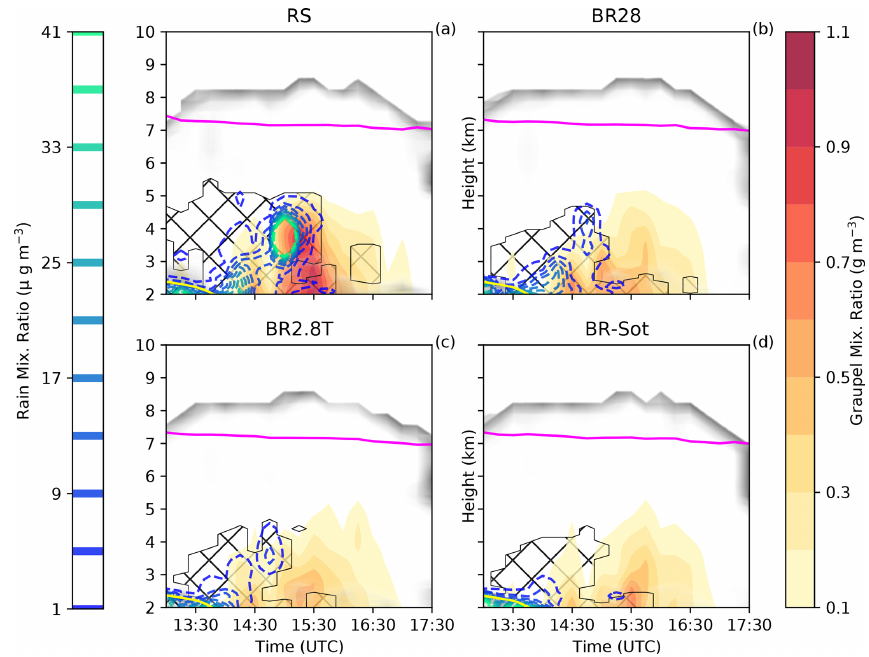
Figure 8. Hovmöller diagrams of graupel and rain mixing ratio for panels (a) RS, (b) BR28, (c) BR2.8T and (d) BR-Sot between 13:00 and 17:30UTC. The hatched area is defined as the MPC where the cloud droplet mass concentration and ice mass concentration are greater than 10 and 0.1mgm − 3 , respectively. The pink line is the homogeneous freezing line at − 38 ◦ C, and the shaded gray area is the cloud area fraction.